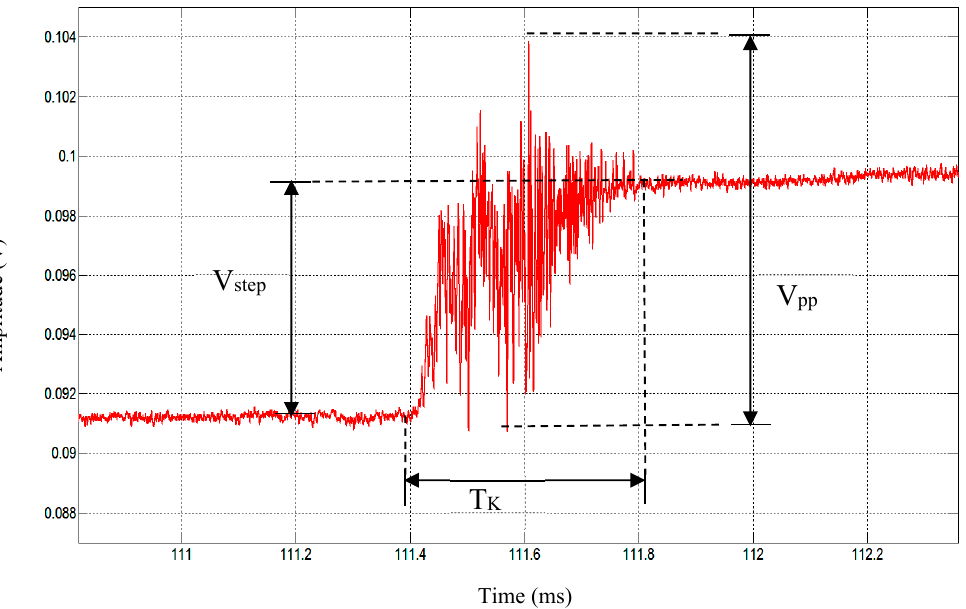
Figure 3. First K-change in Figure 2( c ) in an expanded time-scale presenting the measured parameters T K , V step , and V pp . The signal was recorded by the slow antenna system.